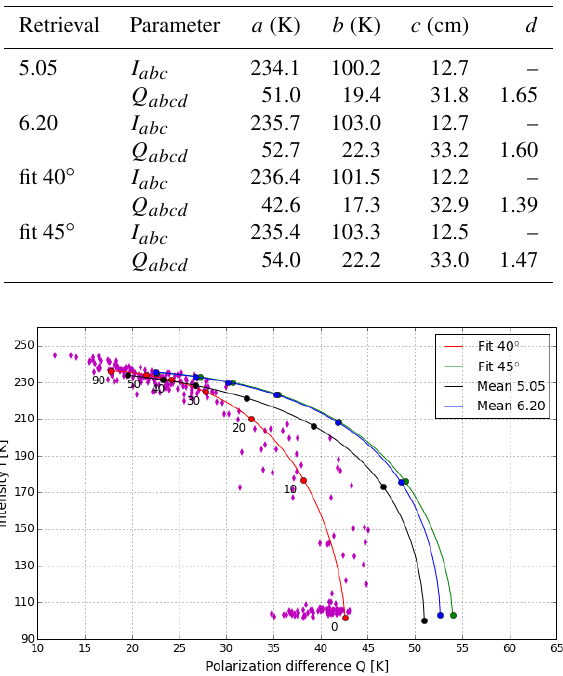
Table 1. Sea ice thickness retrieval curve parameters for the original 5.05 data version training and 6.20 training, and the two fit curve parameters for 40 and 45 ◦ incidence angle.